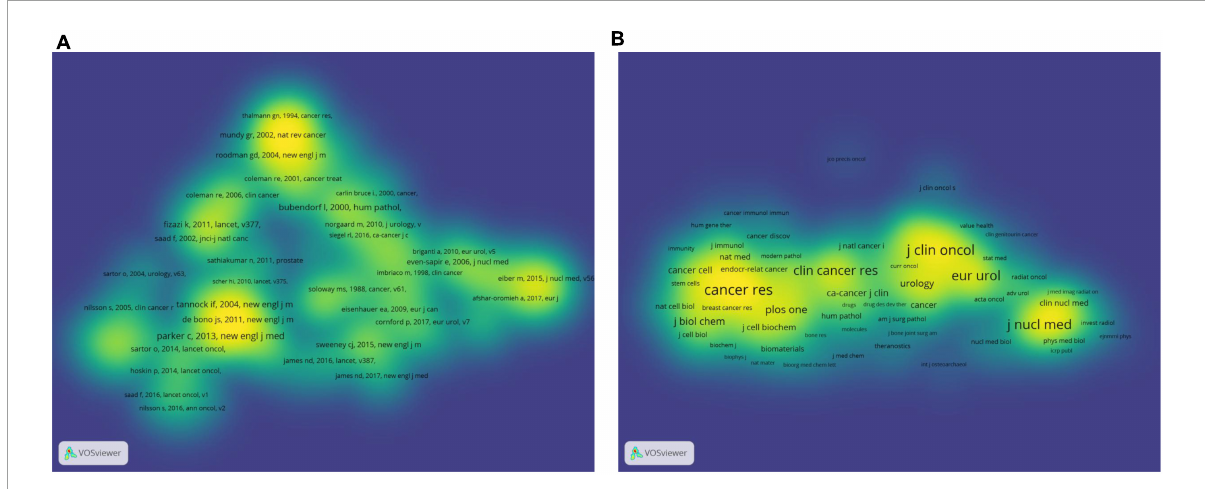
FIGURE7 The bibliometric analysis of the co-citation in the field of PCa bone metastasis. (A) The density visualization map of co-cited references in the field of PCa bone metastasis. (B) The density visualization map of co-cited journals in the field of PCa bone metastasis.